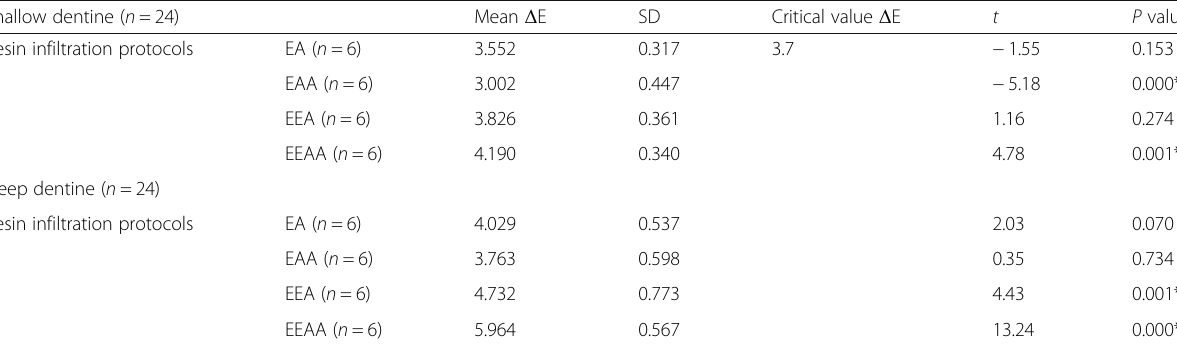
Table 3 Comparison between the mean Δ E (T2-T0) following various resin infiltration protocols of the WSLs in dentine and the threshold of clinical detection Shallow dentine ( n = 24)